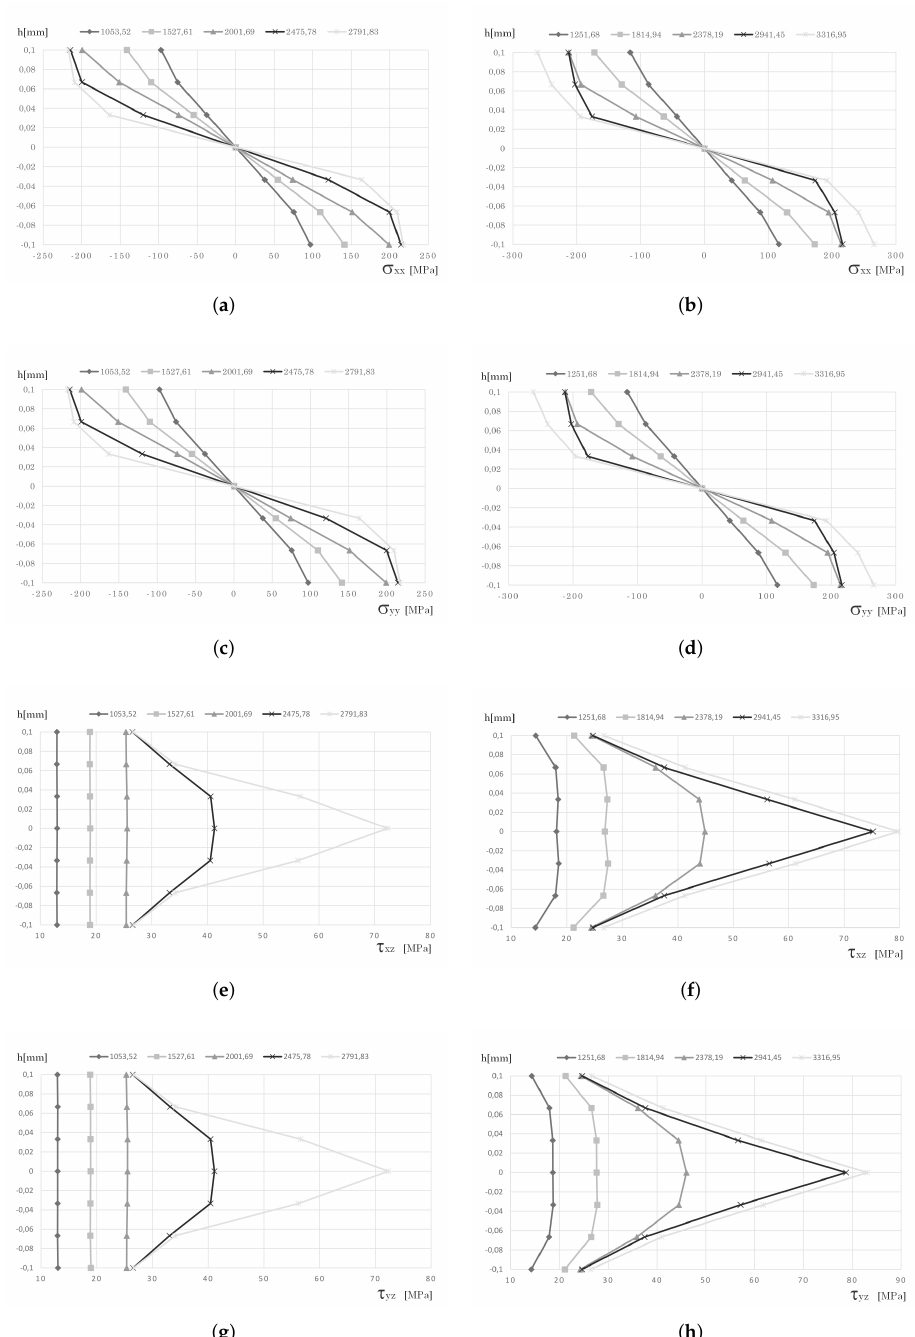
Figure 6. Stress distribution along the thickness in line A-A’ for the clamped. FEM analysis ( a ) σ xx , ( c ) σ yy , ( e ) τ xz and ( g ) τ yz . RPIM analysis ( b ) σ xx , ( d ) σ yy , ( f ) τ xz and ( h ) τ yz . Load increments in [kN/m 2